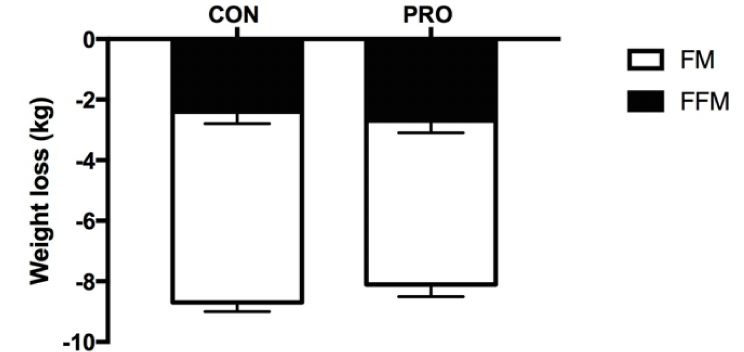
Figure 3. Body composition changes from baseline to the end of the intervention after 4 weeks. Data presented as mean ±